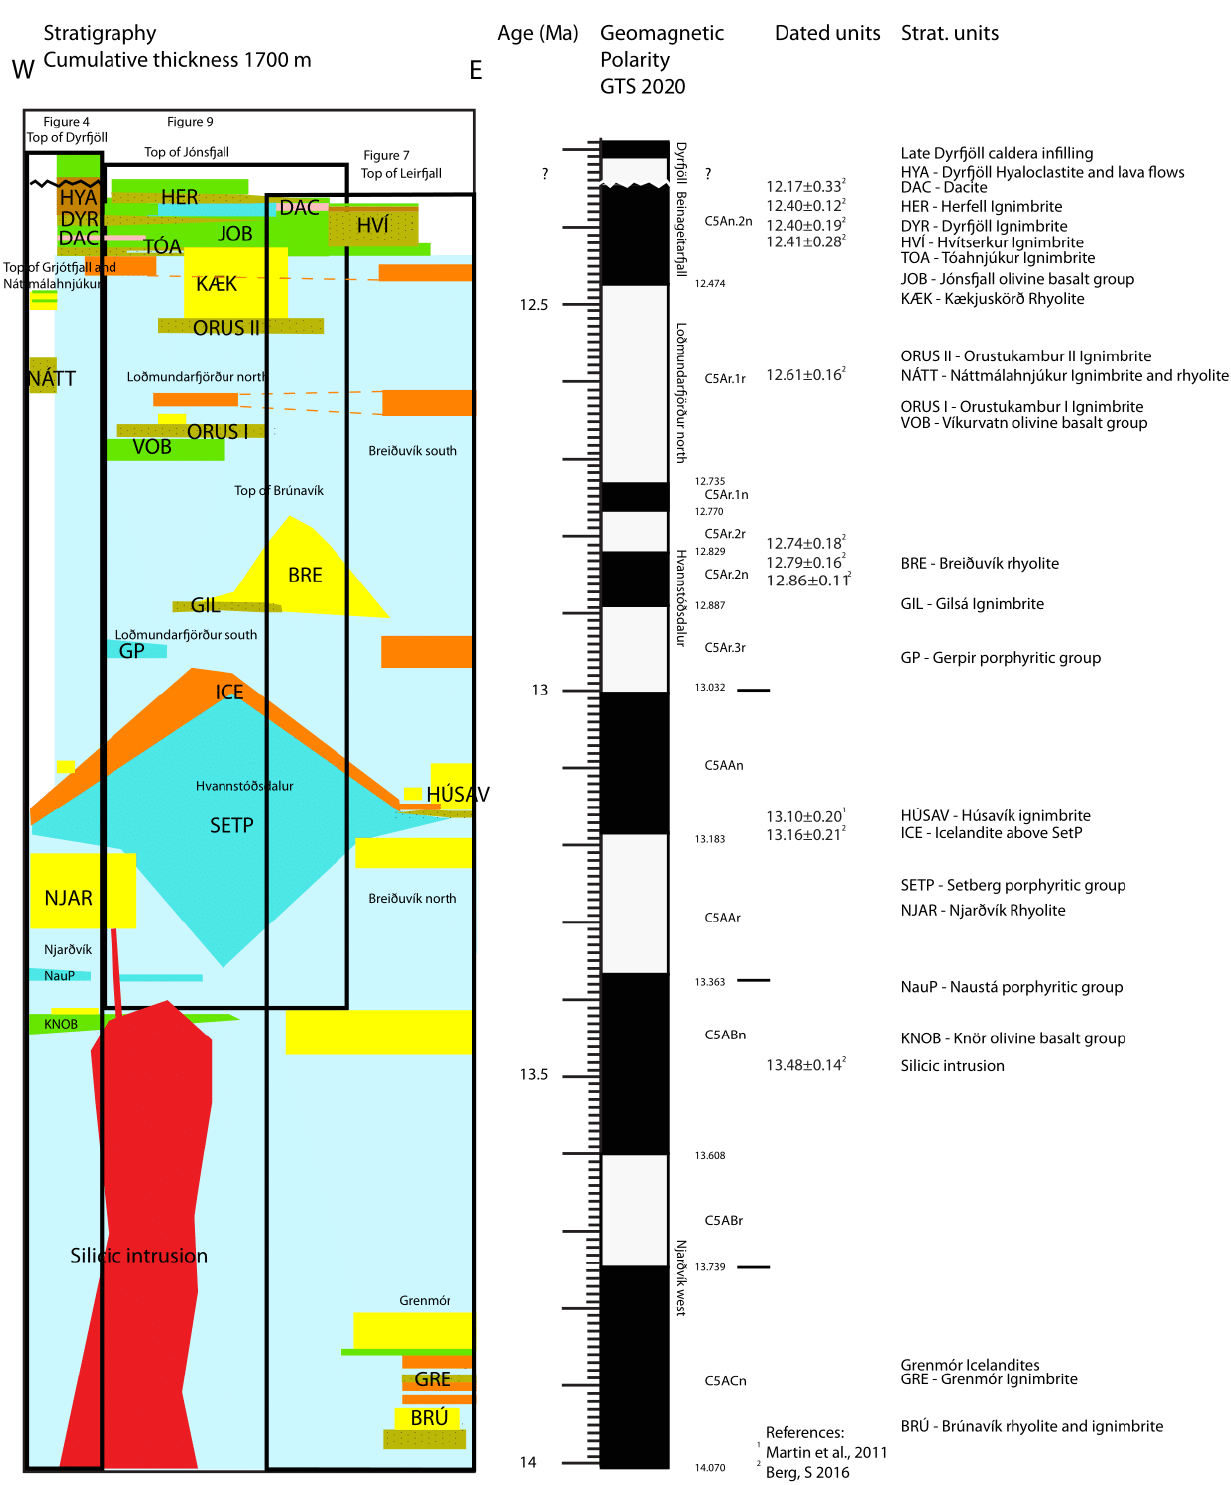
Figure 15: Composite stratigraphic section showing the order of the geological formations described in the text as correlated with the magnetostratigraphy (this study) and the available radiometric